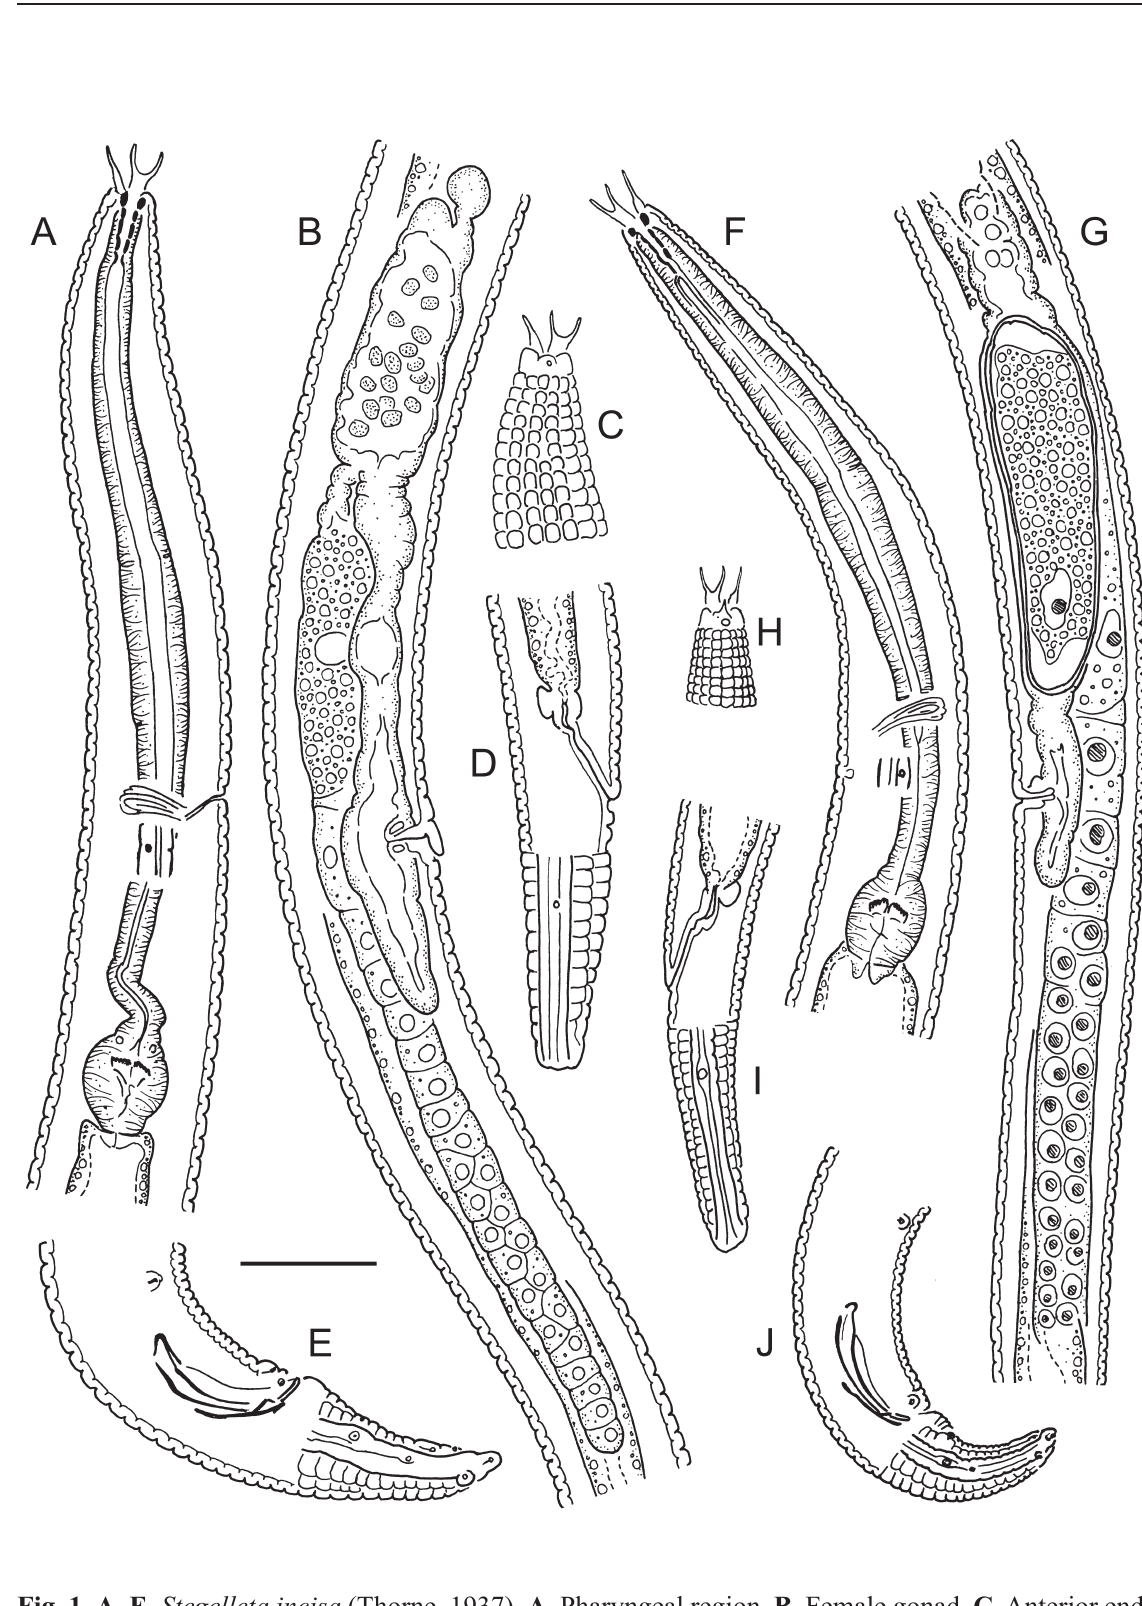
Fig. 1. A–E . Stegelleta incisa (Thorne, 1937). A . Pharyngeal region. B . Female gonad. C . Anterior end, surface view. D . Female tail. E . Male tail. F–J . Stegelleta laterocornuta sp. nov. F . Pharyngeal region. G . Female gonad. H . Anterior end, surface view. I . Female tail. J . Male tail. Scale bar = 20